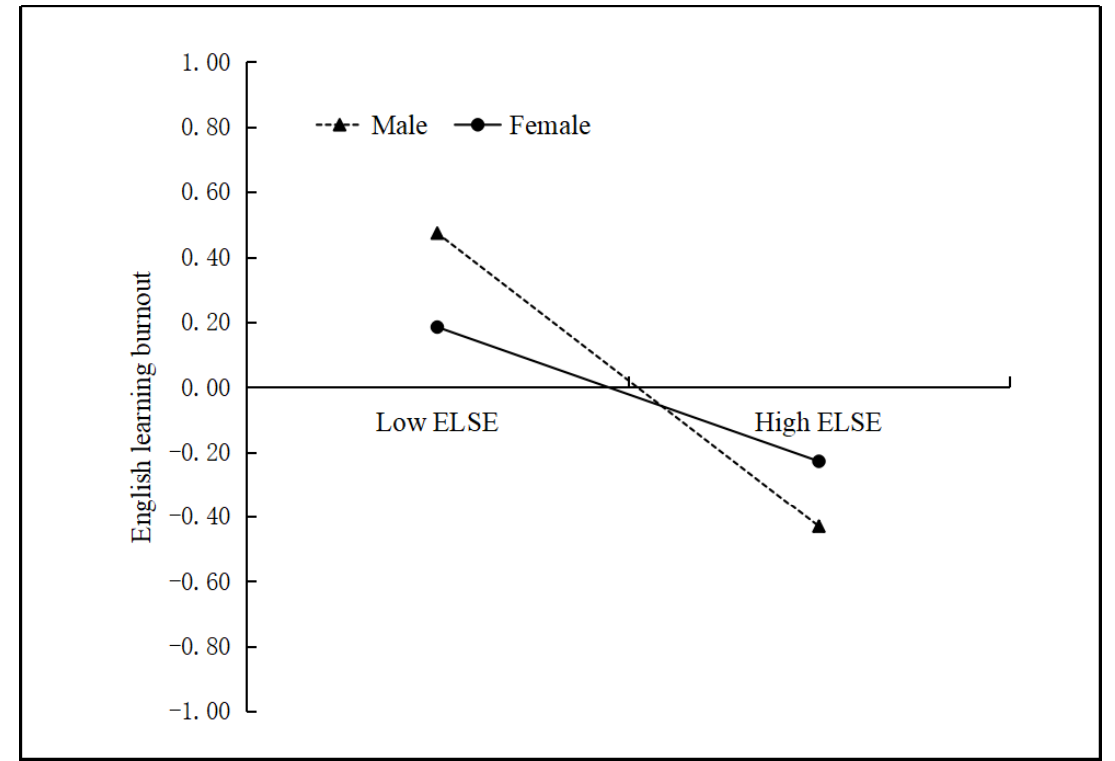
Figure 3. English learning burnout as a function of English learning self-efficacy and gender. ELSE = English learning self-efficacy.